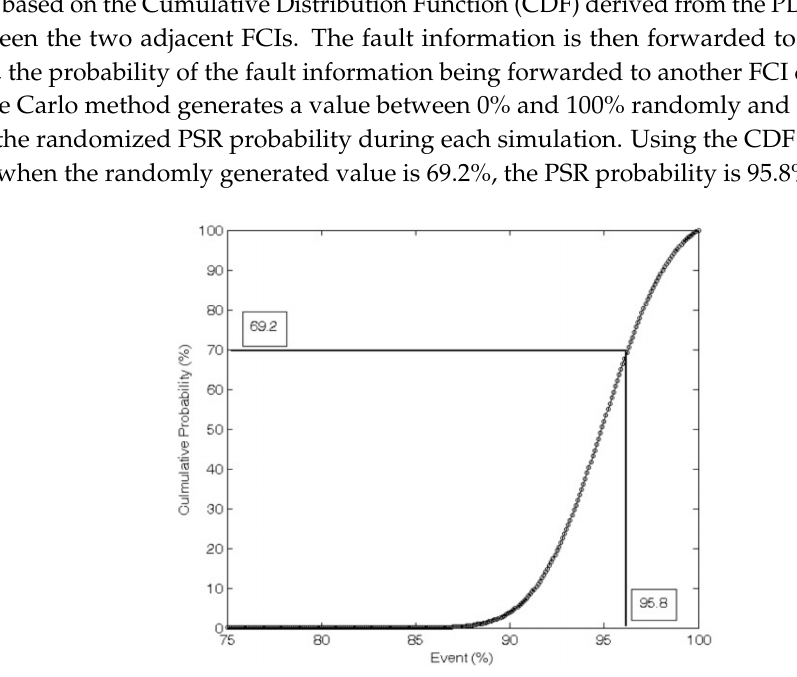
Figure 12. Event probability for stochastic analysis based on the Monte Carlo